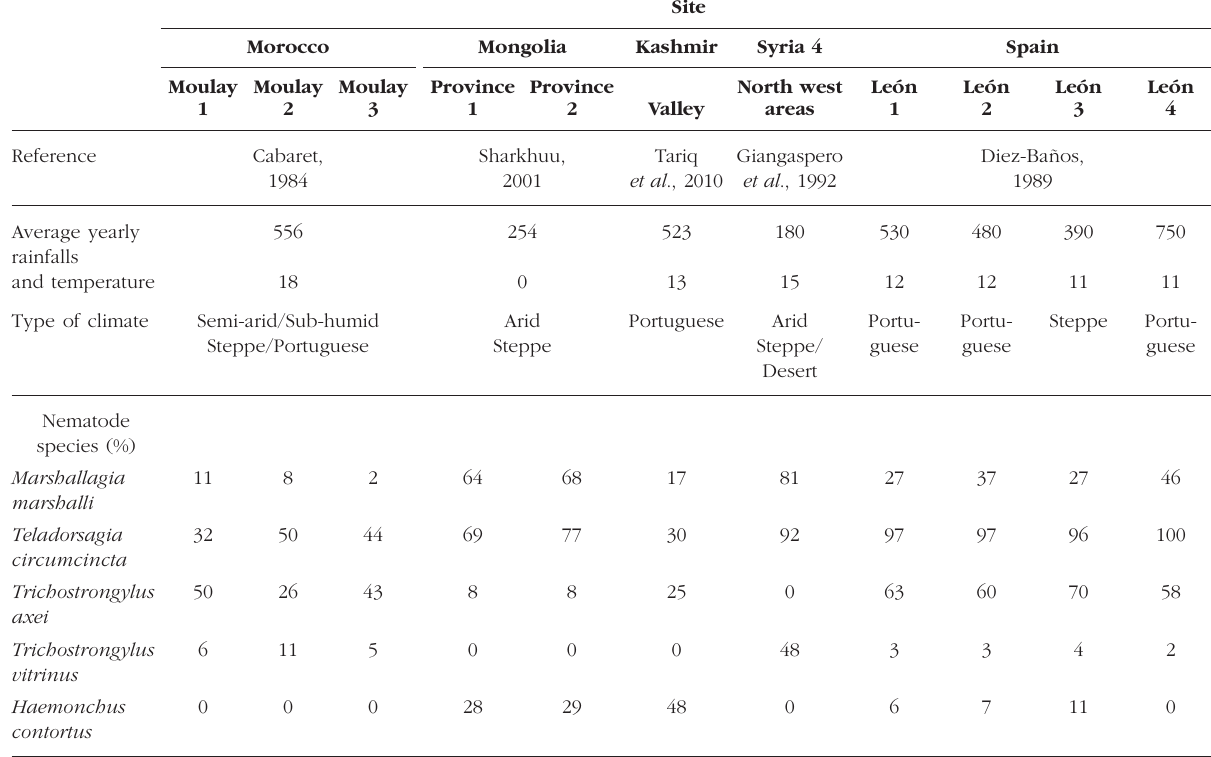
Table II. – Proportions within the community of nematodes species of sheep and goats based on necropsies